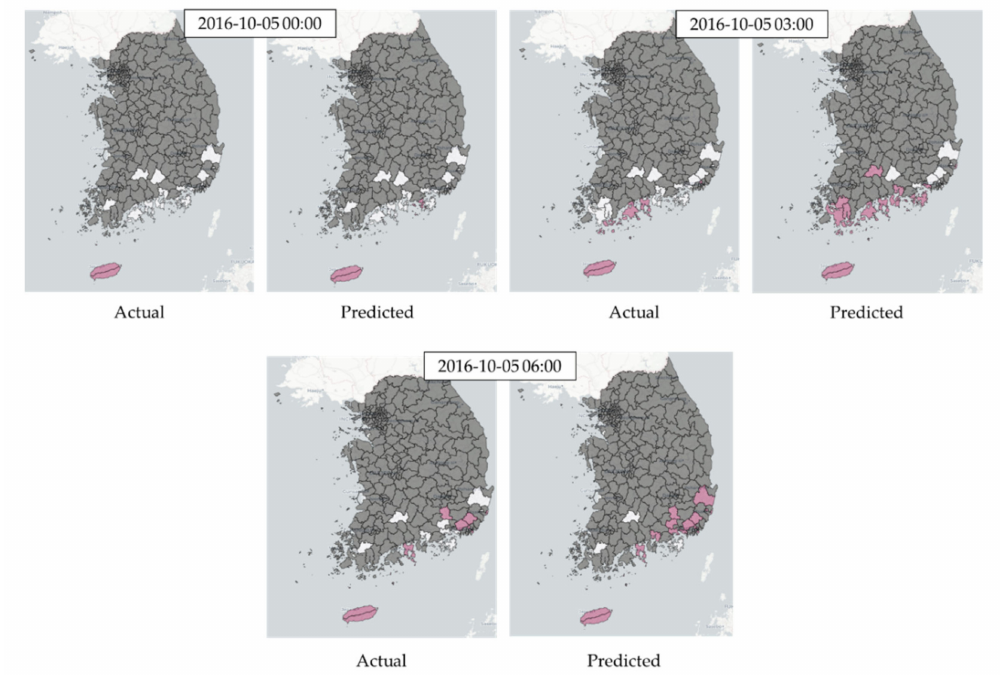
Figure 7. Comparison between the spatial distribution of actual grid state and forecasted grid state for heavy rain in October